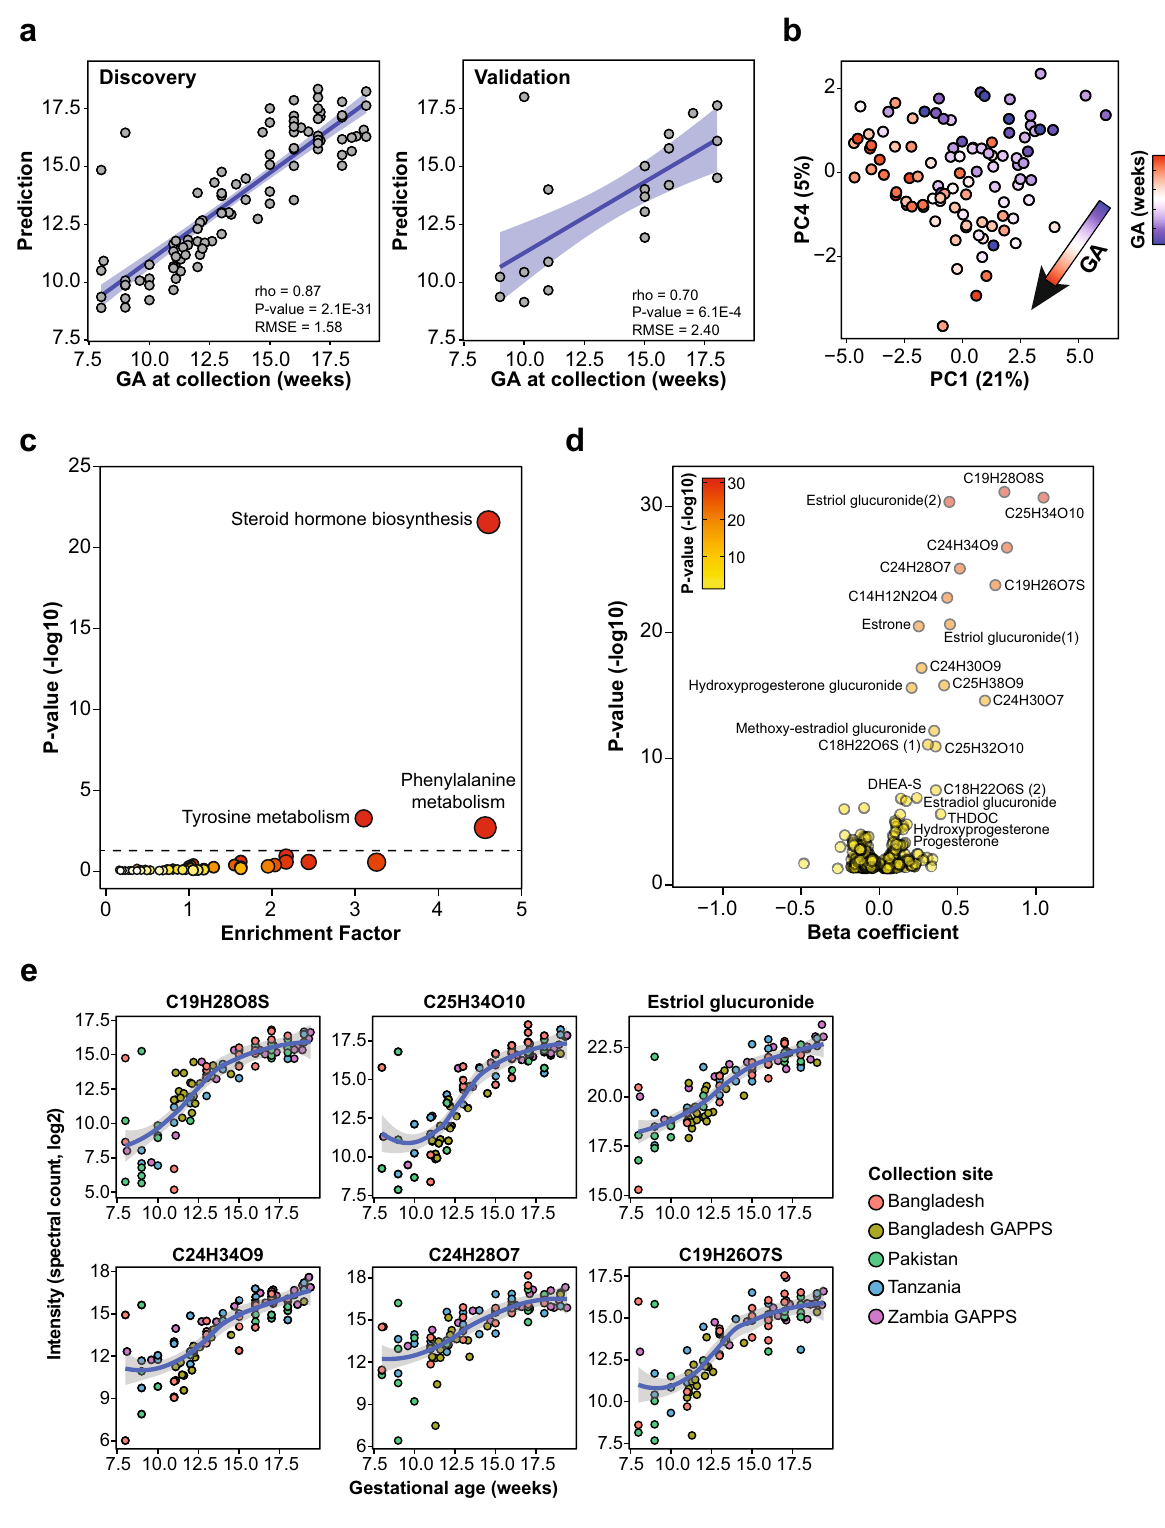
Figure 2. Prediction of gestational age at time of collection and associated biological processes. ( a ) Performance of the restricted RF prediction model of GA that uses three metabolites (C19H26O7S, C24H30O9 and estriol glucuronide) and all the samples in the study (n = 99). The model was validated in an independent cohort (n = 20). The blue area represents the 95% confidence interval. ( b ) Principal component analysis using predictive metabolites ( P -value < 0.05). PC1 and PC4 were chosen because they associated the most strongly with GA. ( c ) KEGG metabolic pathway enrichment analysis. ( d ) Volcano plot of annotated significant metabolites ( P -value < 0.05). Beta coefficients were calculated using a linear modeling and P -values were calculated from Spearman correlations. ( e ) Top 6 metabolites in the predictive model and LOESS fit across all the samples. The grey area represents the 95% confidence